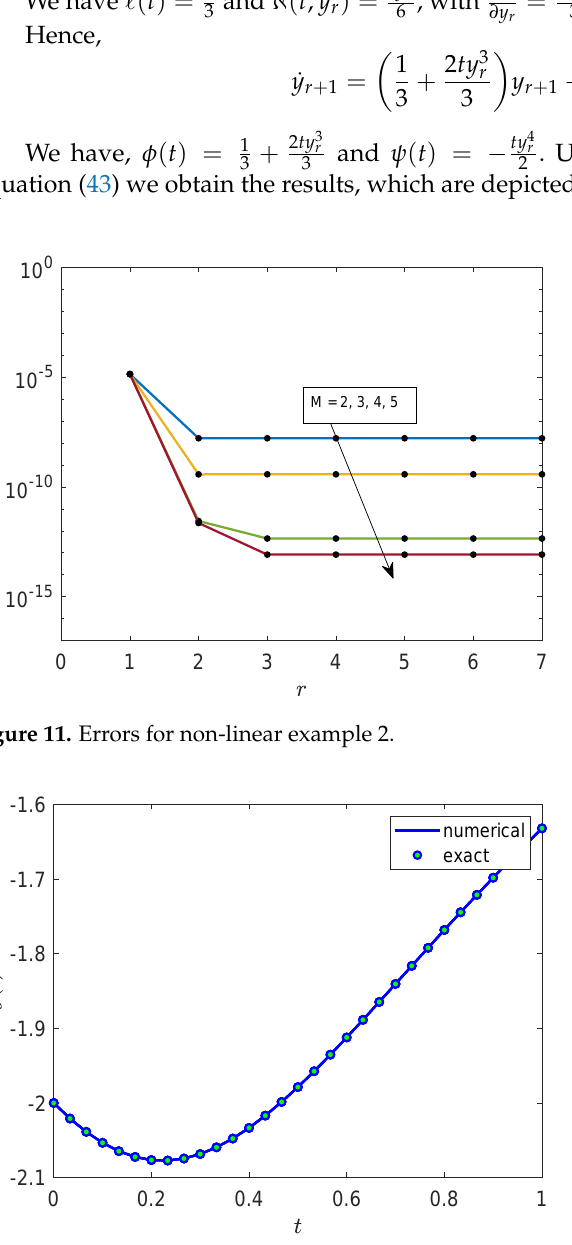
Figure 12. Graphs of the exact and approximate solutions for example